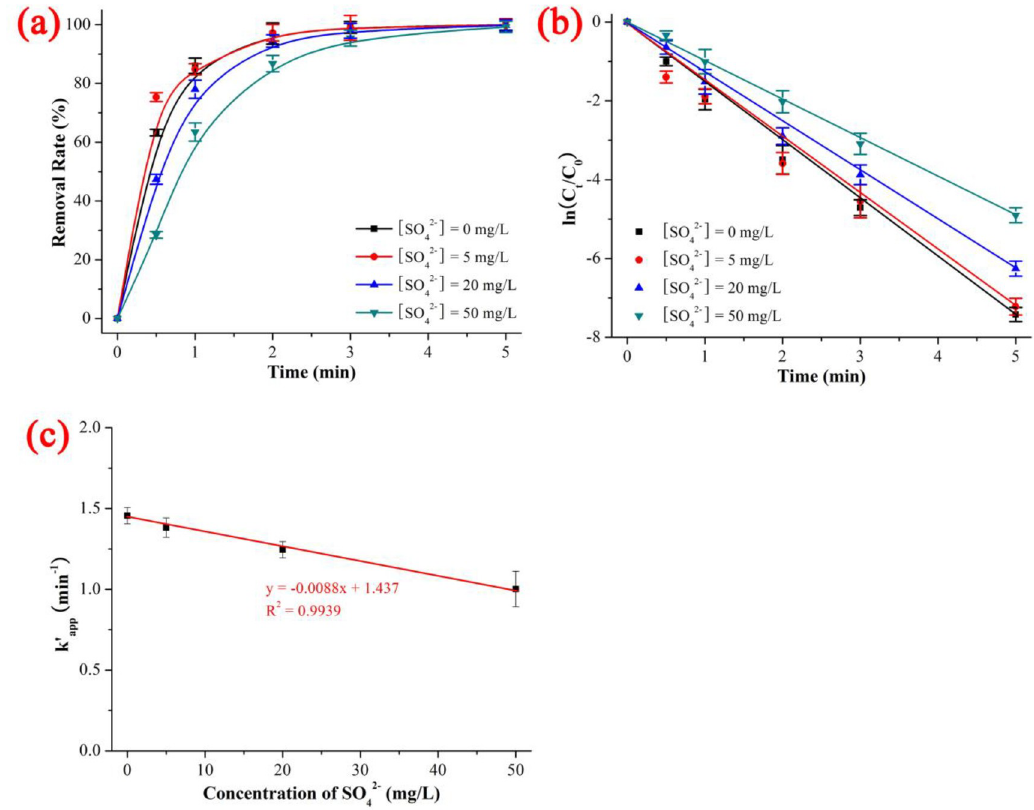
Fig 5. Effect of SO 42- on the removal rate (a), kinetics constant (b) and linear fitting between kinetics constant and concentration of SO 42- on the degradation of NIF via UV/H 2 O 2 . The error bars represent the standard deviation (n = 3). concentration = 0–50 mg/L, pH = 7, H O dose = 0.52 mmol/L, T = 20 ˚C and reaction 2 2 time = 5 min. As shown in Fig 5C, the degradation kinetics of NIF via UV/H O system exhib- 2 2 ited a good linear decrease as the SO 42- concentration increased (y = -0/0088x + 1.437, R 2 = 0.9939). The inhibition effect was 5.08% (SO 42- concentration = 5 mg/L) < 14.45% (SO 42- con- centration = 20 mg/L) < 31.20% (SO 42- concentration = 50 mg/L), which was in keeping with the trend of the kinetics constants: 1.00154 min -1 (SO 42- concentration = 50 mg/L) < 1.24540 2- concentration = 20 mg/L) < 1.38175 min -1 (SO 2- concentration = 5 mg/L). The min -1 (SO 4 4 degradation rate of NIF decreased with increasing SO 42- concentration, and the quenching mechanism of ROS via SO 42- is shown in (Eq 12) to (Eq 17) [37]: (cid:0) H þ þ SO 42 (cid:0) ! HSO 4